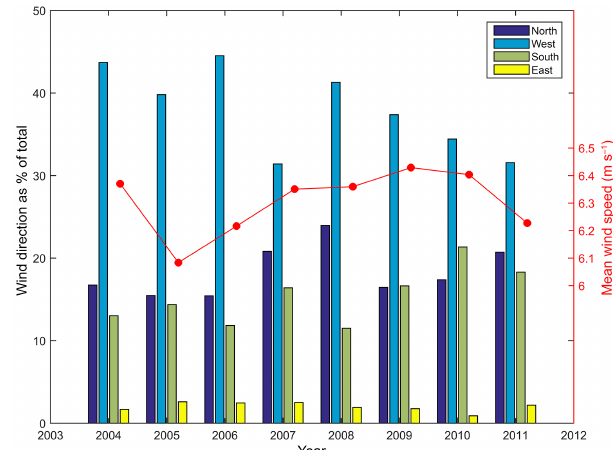
Figure 3. Percentage of wind measured at Hawera in each of four directions (left y axis) and mean wind speed (right y axis) in each growing season (September–April) between 2004 and 2011 (day- light hours only, 08:00–18:00). Directions are defined by ± 30 ◦ due north, west, south, and east (i.e. west is defined as wind from 240 to 300 ◦ ). Note that this does not comprise the complete 360 ◦ circle so percentages do not add to